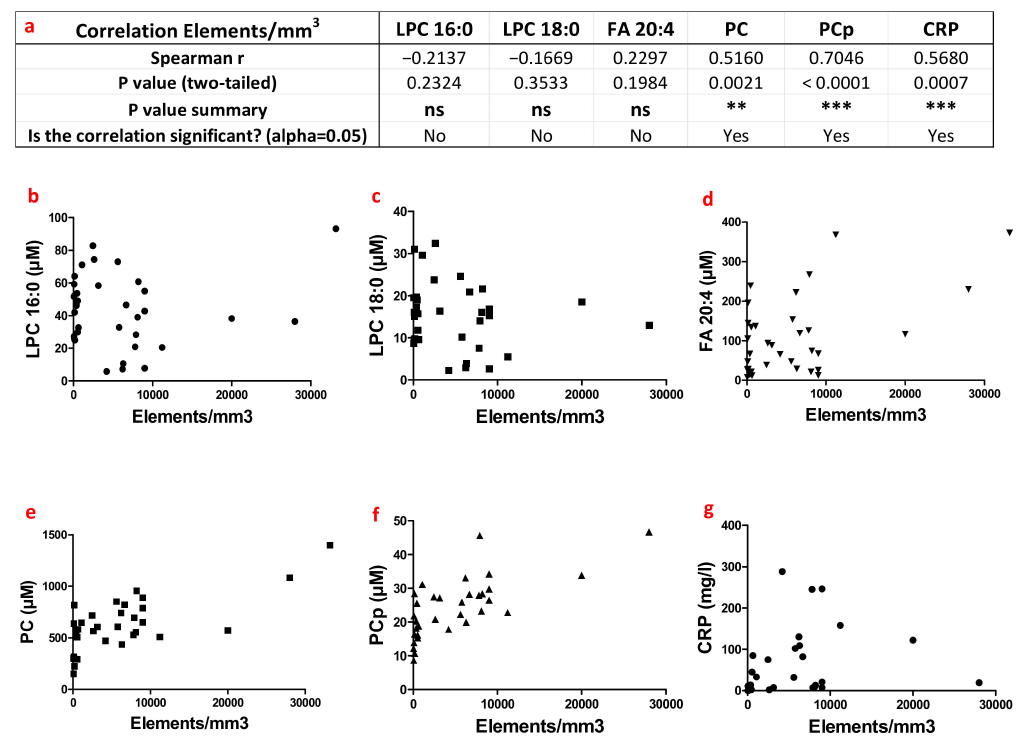
Figure 7. Assessment of potential associations between the number of cellular elements in human synovial fluids and the variation of lipid levels. ( a ) Table of Spearman correlation between the number of cellular elements per mm 3 of synovial fluids and lipid concentrations (in µ M) in the synovial fluids. ( b – g ) Correlation plots of the number of cellular elements with LPC16:0, LPC18:0, FA20:4, PC, PCp and C-Reactive Protein levels, respectively. ns: not significant p > 0.05, **: 0.001 < p < 0.01 and ***: p < 0.001. Table 1. Results of the Spearman correlative study between plasmatic concentrations of (cholesterol, HDL, LDL, TG and glucose), and lipid levels in the synovial fluids of the same patients irrespective of the rheumatic